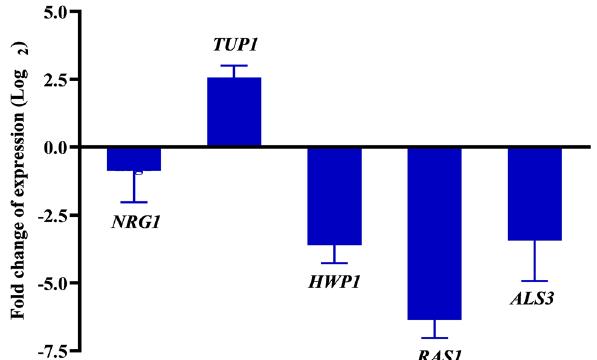
Figure 16. Expression profiles of used candidate genes at transcriptomic level after treatment with catechol at 37° C for 8 h. The genes responsible for adhesion, filamentous growth and biofilm formation such as HWP1 , RAS1 , and ALS3 were significantly downregulated in catechol treated cells. TUP1 , a negative transcription regulator of filamentation was upregulated. The relative gene expression was calculated by 2 −ΔΔCT method using C. albicans ITS region as housekeeping internal control gene. Error bars indicates the mean values of three experimental duplicates. The “* “and “**” symbols represents the statistical significance of p < 0.05 and p < 0.01,